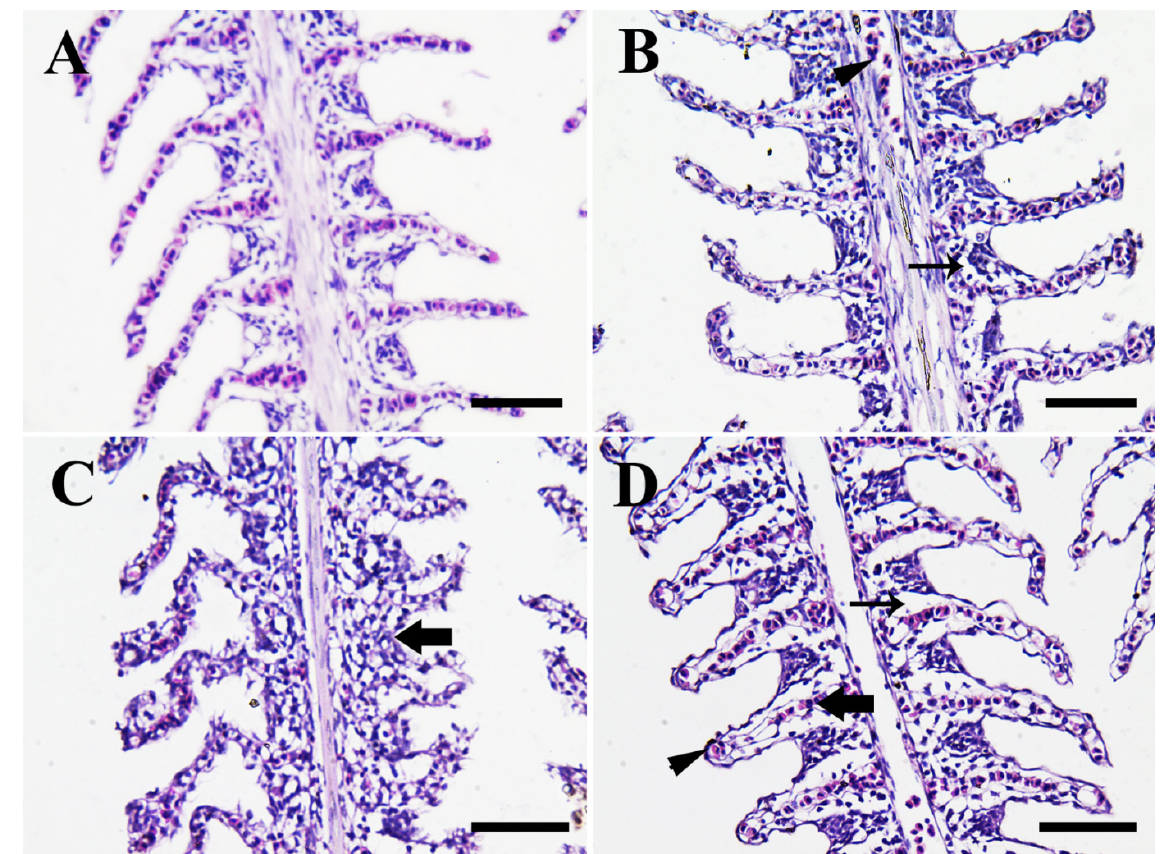
Figure 7. Representative photomicrographs in the gills of Nile tilapia juveniles (H & E stain, scale bar = 50 µm) of the control group ( A ), and CuONPs-exposed fish at 10 mg/L ( B ), 20 mg/L ( C ), and 50 mg/L ( D ) values, respectively for 25 days. ( A ) shows normal gill architecture, primary and secondary gill lamellae. Meanwhile, ( B ) shows slight dilation of primary and secondary lamellae due to edema (arrow) and slight congestion (arrowhead). ( C ) shows epithelial necrosis, desquamation, fusion, and epithelial layer rupture (arrow), and ( D ) shows severe edema (thin arrow), sever congestion of secondary lamellae (thick arrow), and telangiectasis of the secondary lamellae (arrowhead).